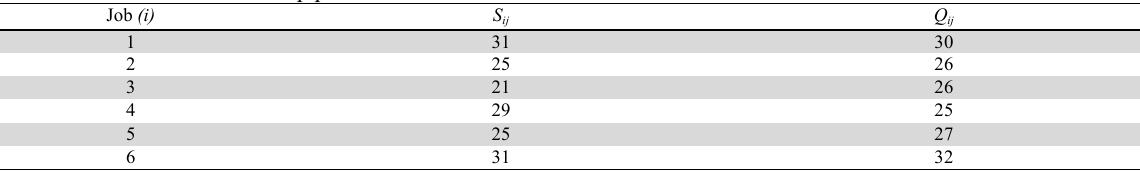
Reduced two-machine flow-shop problem